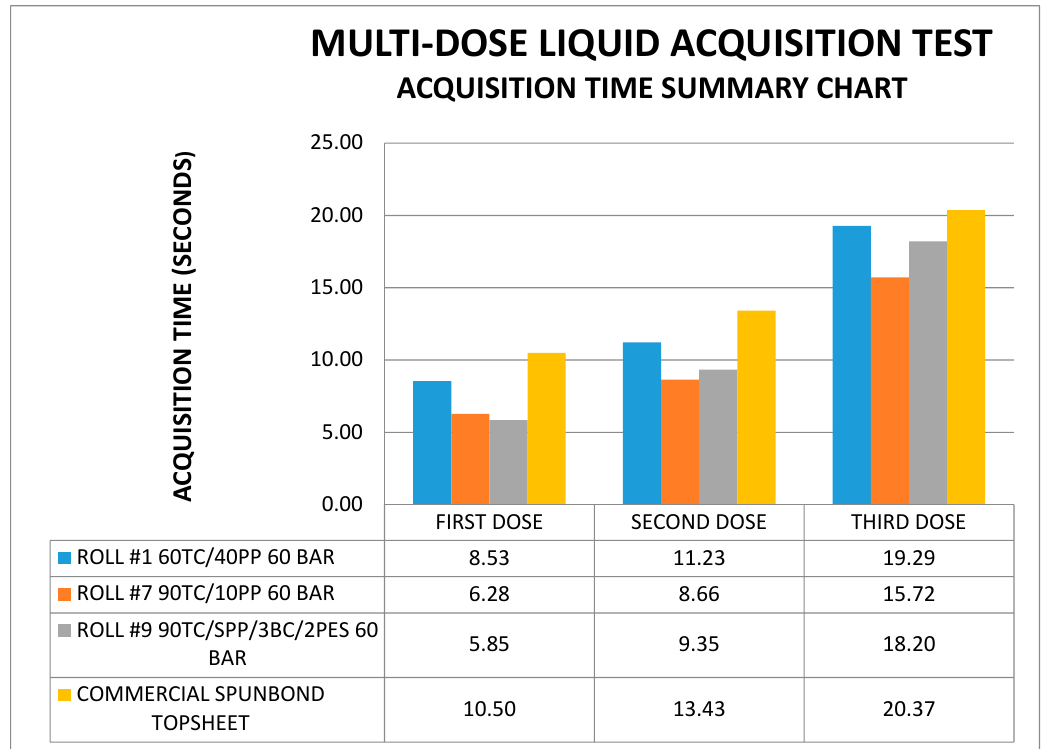
Figure 8. Comparison of liquid acquisition of three nonwoven fabrics and a commercial source.